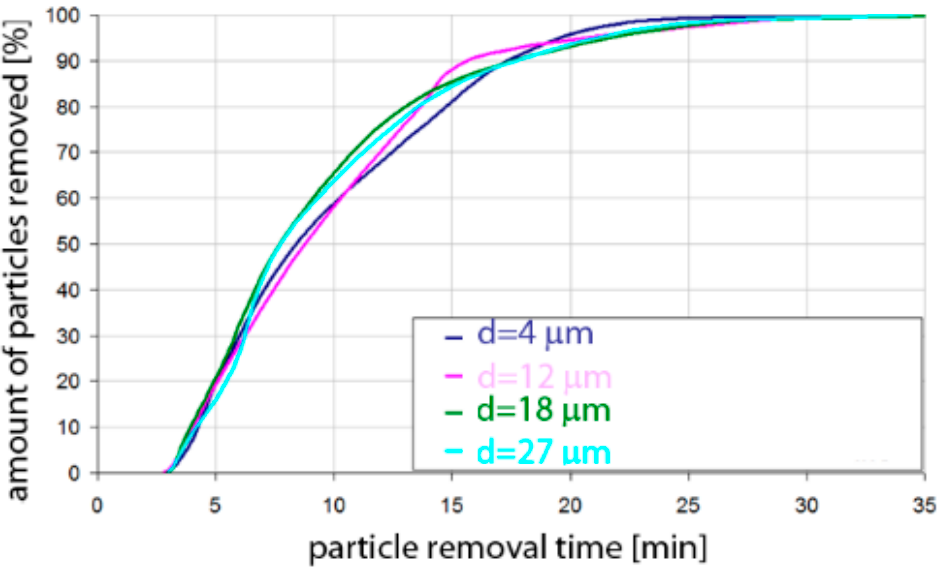
Figure 22. Share of removed non-metallic MnS inclusions from the analysed ladle in the case of argon flow of 50 L/min through the 42CrMo4 steel.